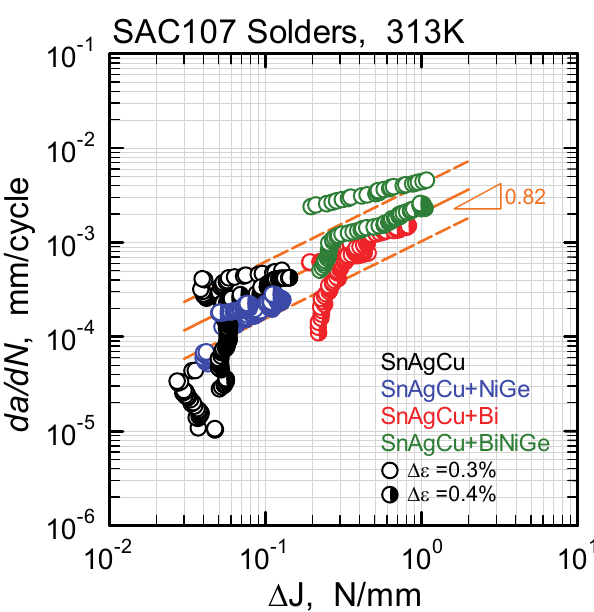
Figure 9: Relationship between crack propagation rate and 